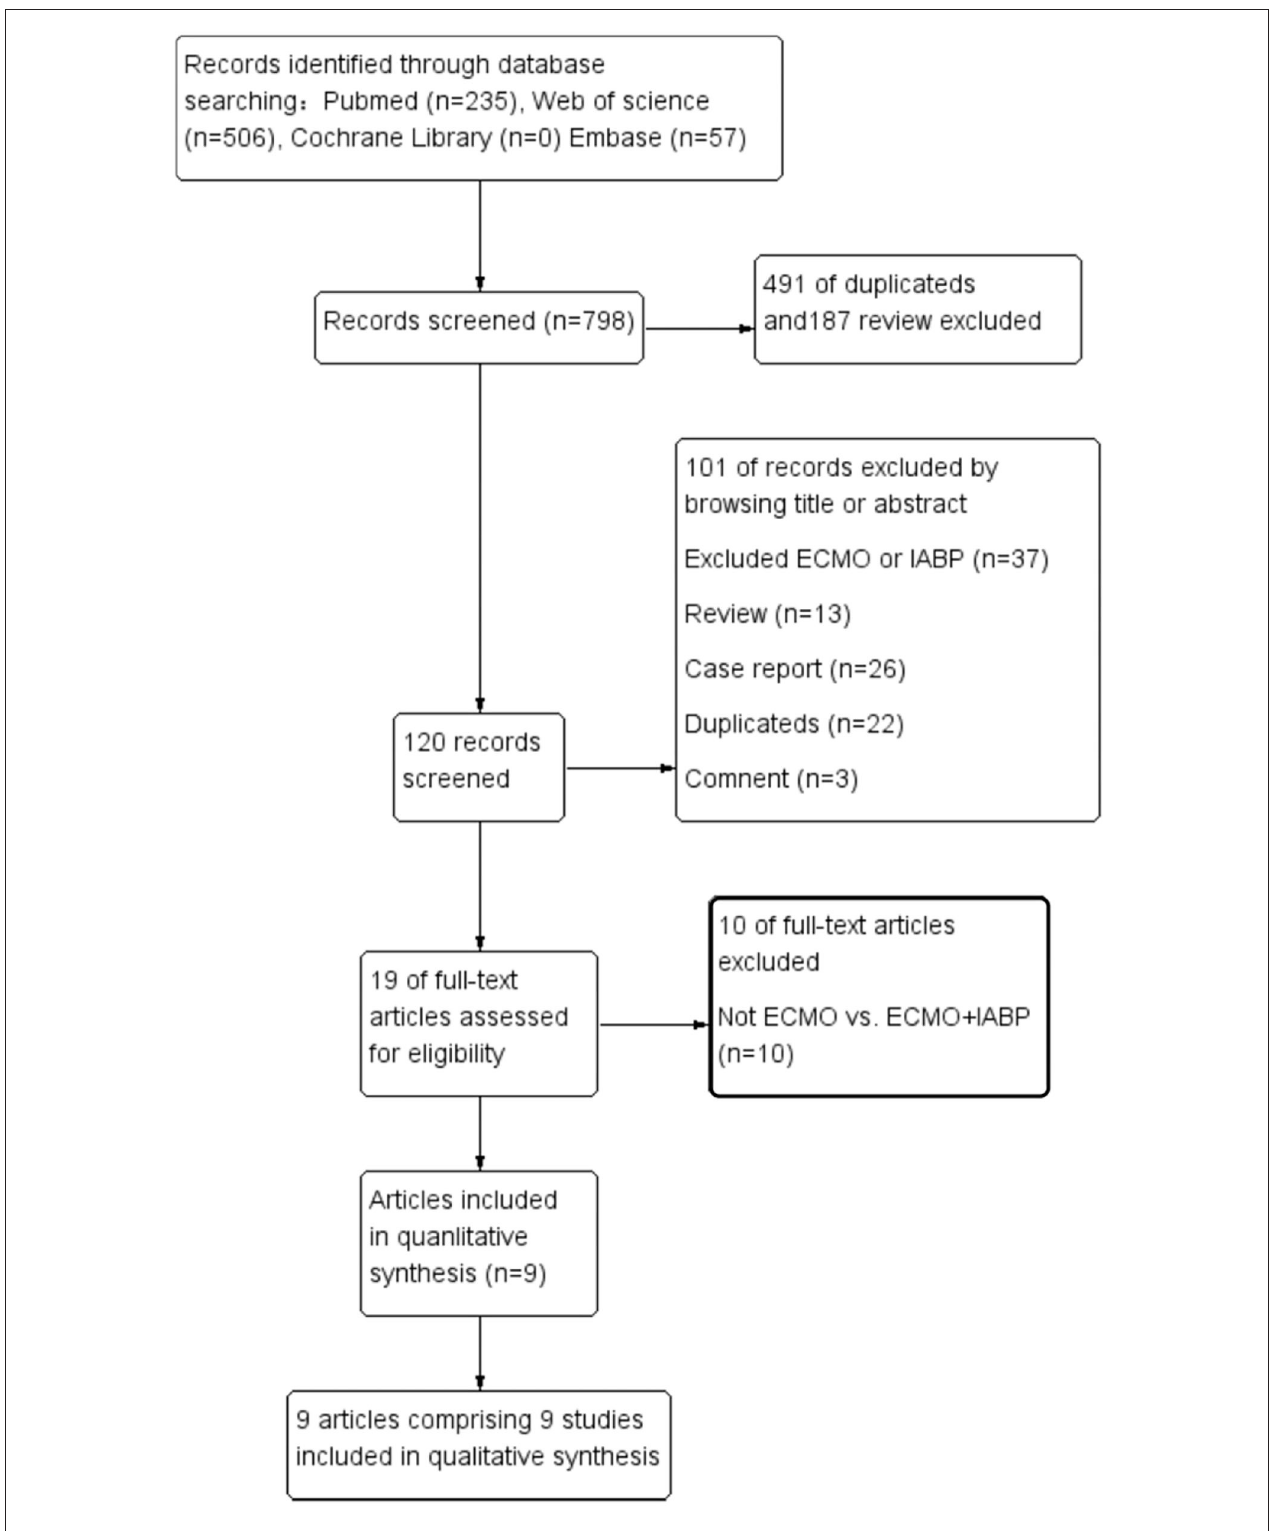
FIGURE 1 | Flowchart of the study selection process in the meta-analyzes.